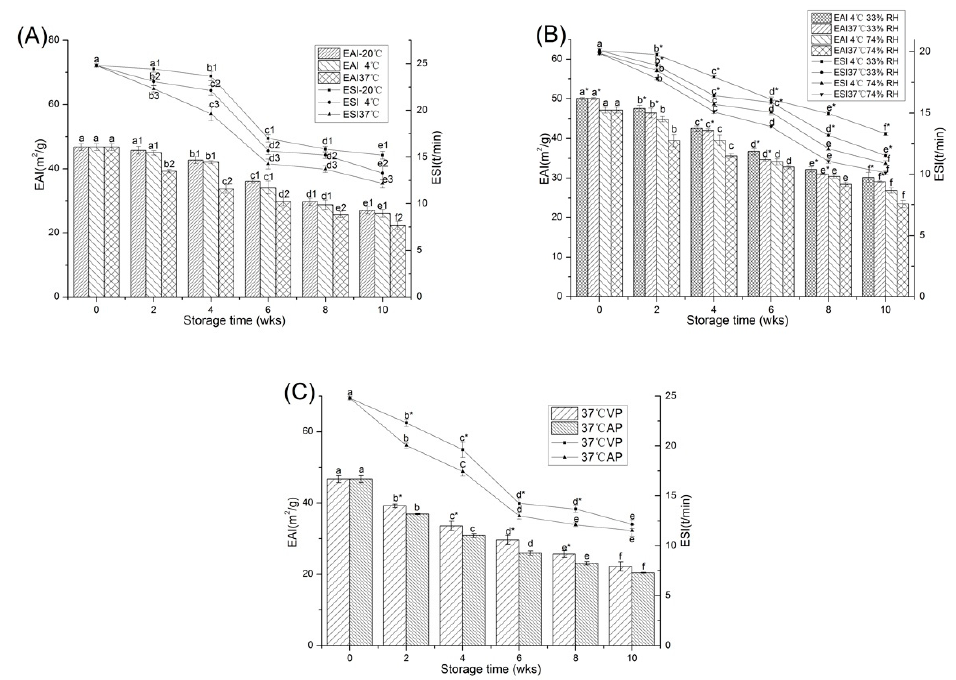
Figure 5. Changes in the EAI and ESI of PPI stored at different temperature ( A ), relative humidity ( B ) and packaging methods ( C ). a–f means the significant difference between the same treatments with different weeks (p < 0.05 ) . 1–3 means the significant difference between the same weeks with different temperature ( A ) (p < 0.05 ) . * means the significant difference between the same weeks and temperature with different relative humidity ( B ) or between the same weeks with different packaging methods ( C ) (p < 0.05 ) .